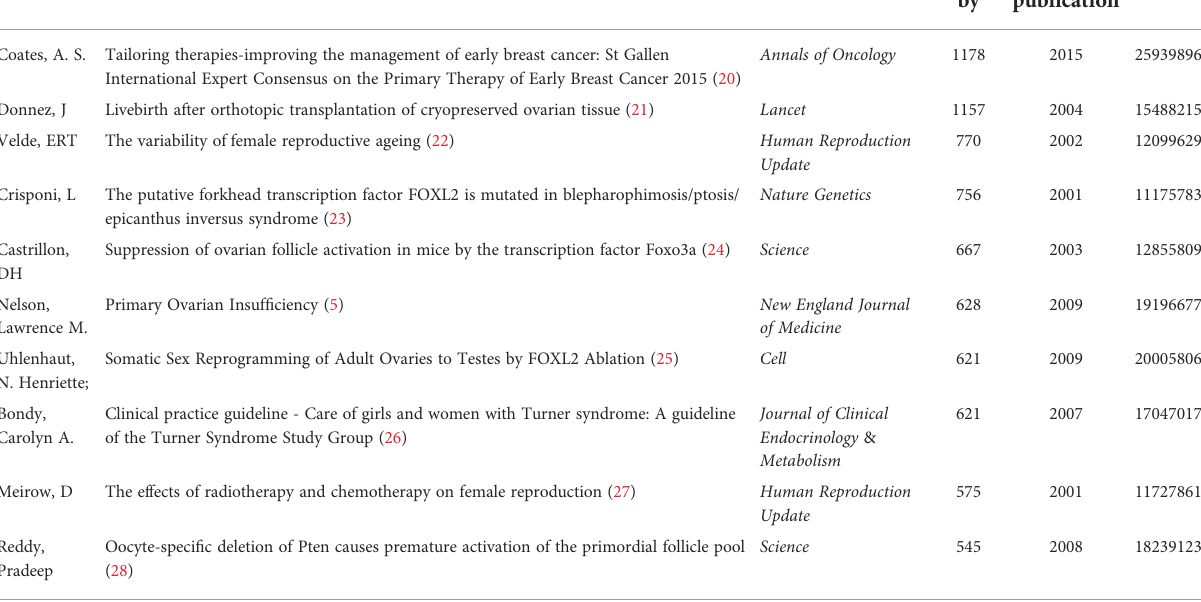
TABLE 4 Top 10 citation analysis of documents on